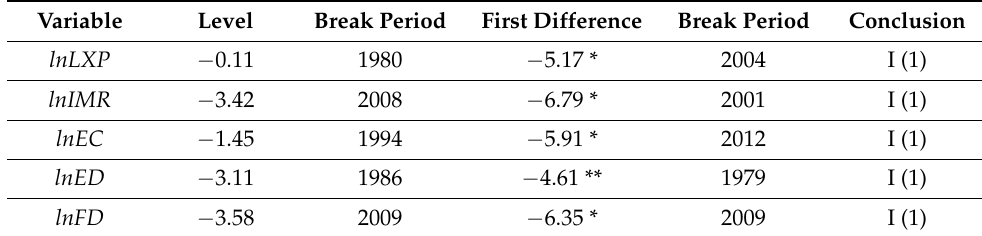
Table 4. ZA Unit Root Test